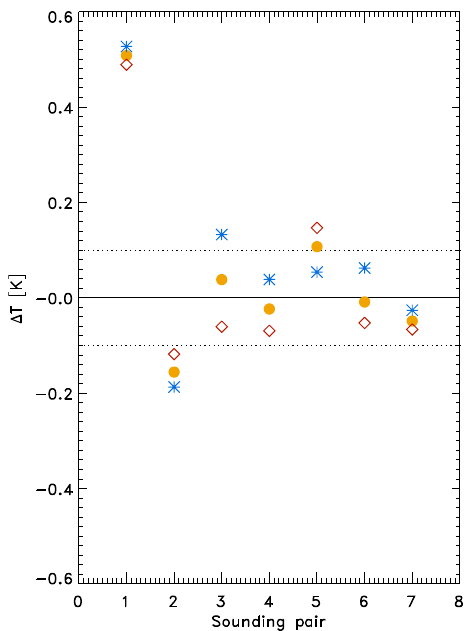
Figure 6. Comparison frost point measurements in dual soundings. Blue dots indicate the tropospheric difference, red dots indicate the stratospheric difference, and large orange dots indicate the mean difference for the entire